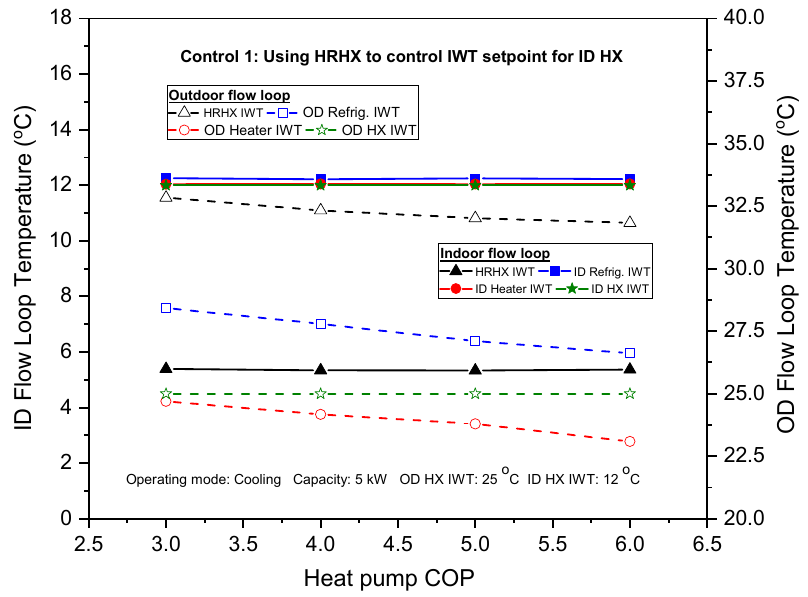
Figure 15. Flow loop temperature with cooling COP variation in control (1).